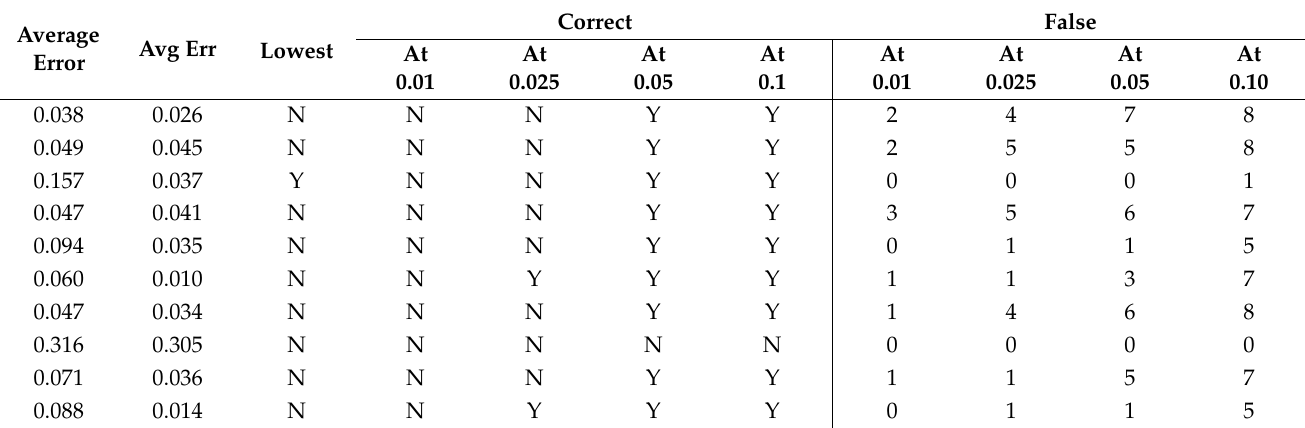
Table A156. Set 2, trials 41–50 summary data (average actual PR values).